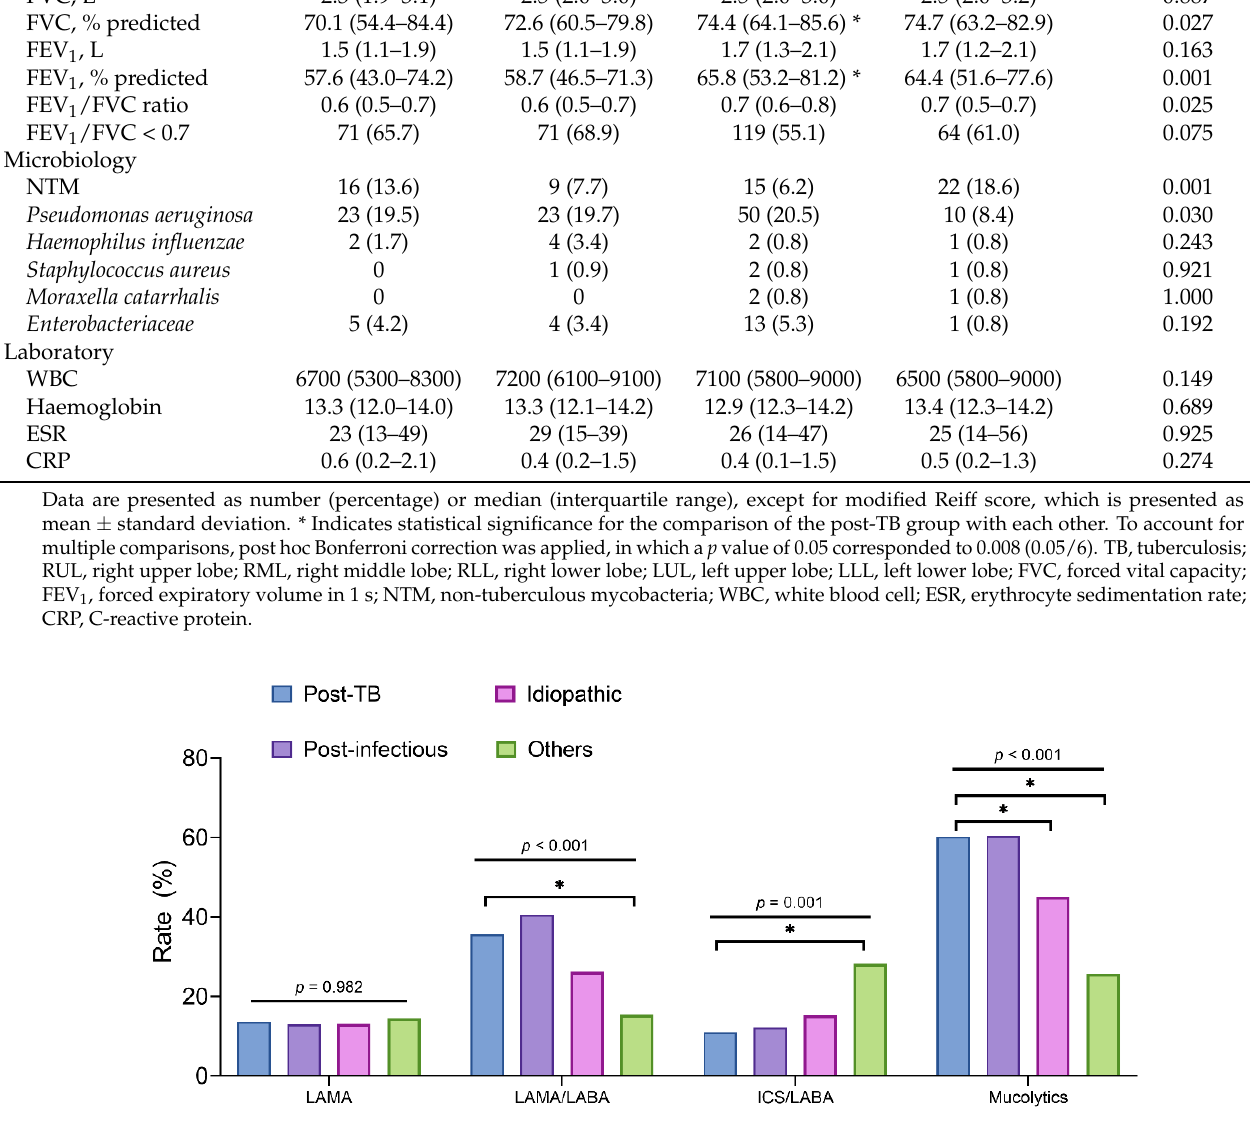
Figure 1. Comparison of respiratory medication use in patients with bronchiectasis according to their aetiologies. * Indicates statistical significance for the comparison of the post-TB group with each other. To account for multiple comparisons, post hoc Bonferroni correction was applied, in which a p value of 0.05 corresponded to 0.008 (0.05/6). TB, tuberculosis; LAMA, long-acting muscarinic antagonist; LABA, long-acting ß agonist; ICS, inhaled corticosteroid; OCS, oral corticosteroid; anti, oral